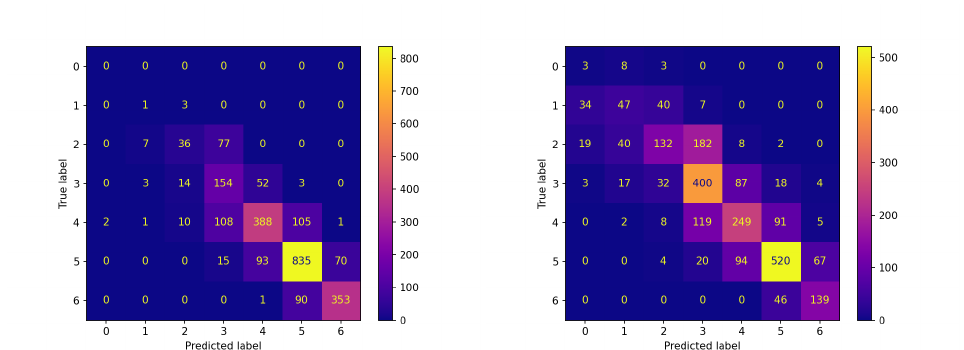
Figure 4. Confusion matrices on the testing set of the best model (model 570) evolved by the non-FL approach on each patient.